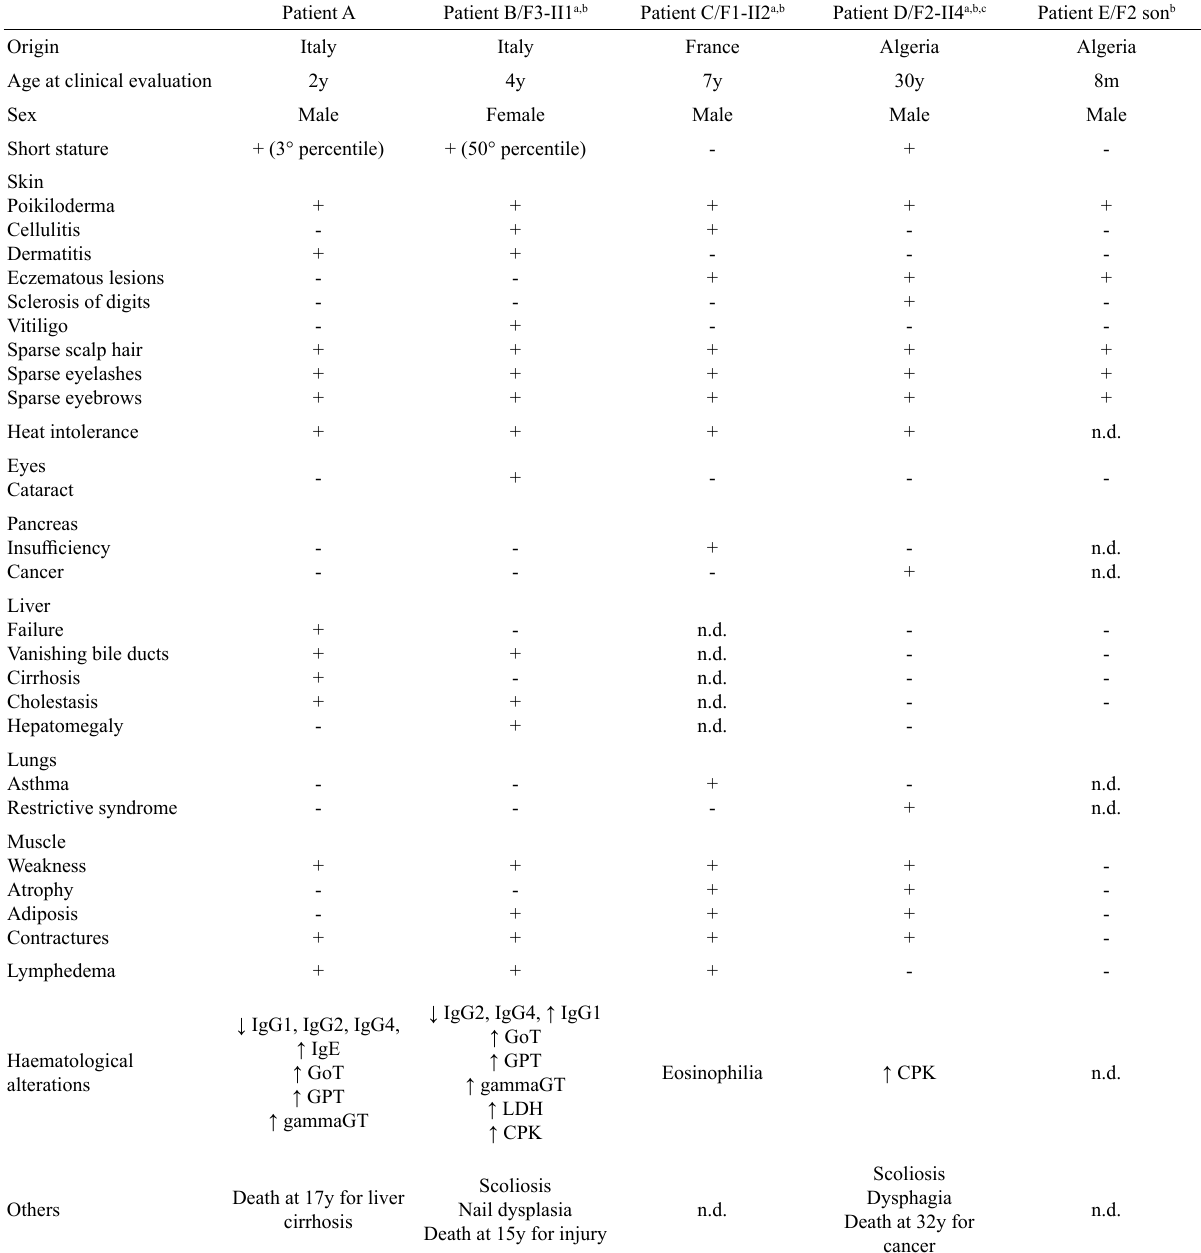
Table 2 – Summary of the clinical signs observed in patients with the c.1879A>G (p.(Arg627Gly)) FAM111B